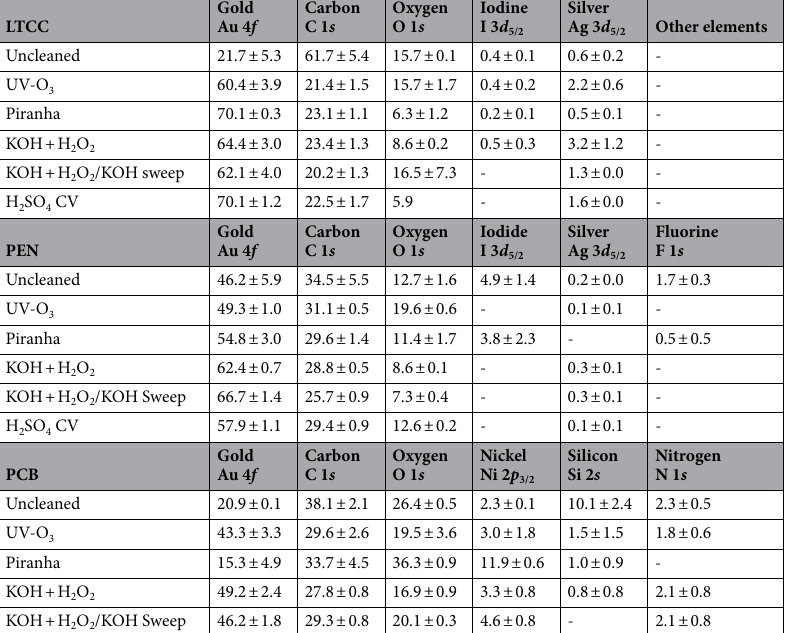
Table 2. Summary of the XPS Analysis of surface composition of different sensor chips before and after cleaning procedures. Elemental concentrations are given in percent. Measurements are averaged over multiple